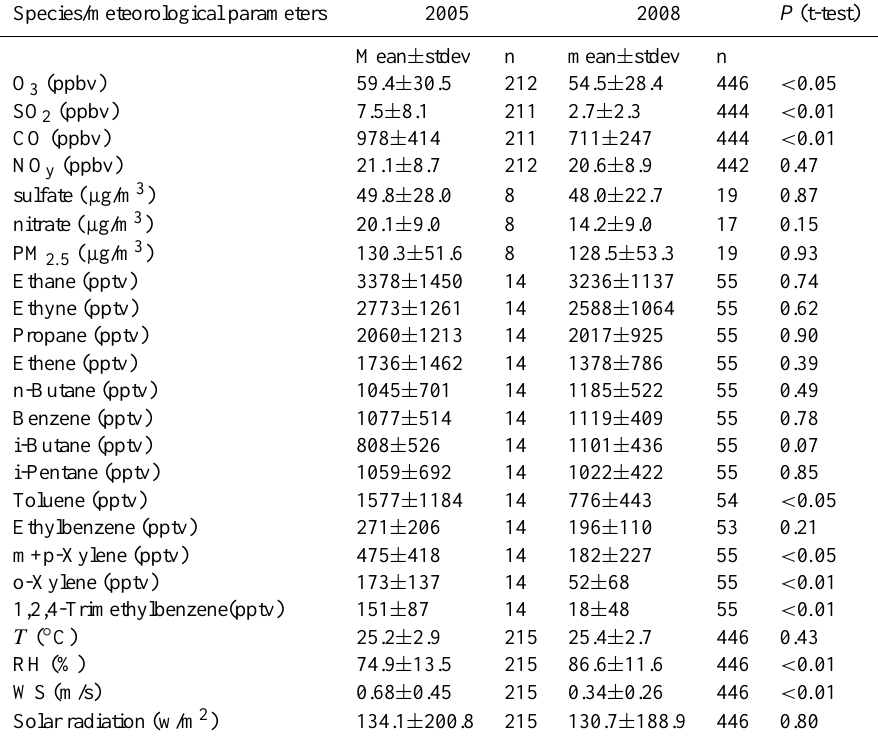
Table 1. Comparison of chemical composition and meteorological parameters in plumes measured at a downwind site in north Beijing in 2005 and